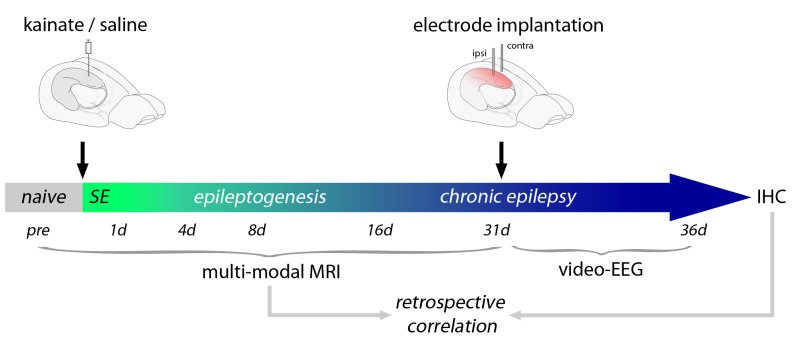
Schematic of the experimental design.Shown is an overview of the workflow applying multi-modal MRI measurements during the time course of epileptogenesis, video-EEG recording in the chronic stage of the disease and post-hoc IHC. Date was retrospectively correlated to probe the predictive value of putative MRI biomarkers.